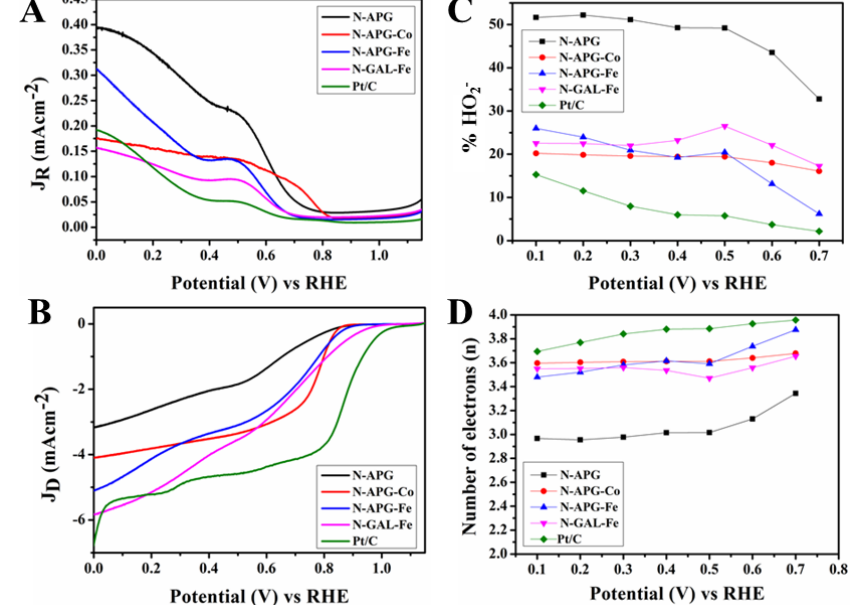
Figure 4. Rotating ring disc voltammograms of ( A ) ring current, ( B ) disc current of N-APG, N-APG-Co, N-APG-Fe, N-GAL-Fe, and Pt/C electrodes in oxygen-saturated 0.10 M KOH at 2000 rpm at a scan rate of 10 mV/s. ( C ) Percentage HO 2 - and ( D ) number of electrons of N-APG, N-APG-Fe, N-APG-Co, and Pt/C electrodes at various potential calculated according to RRDE data. RHE: reversible hydrogen